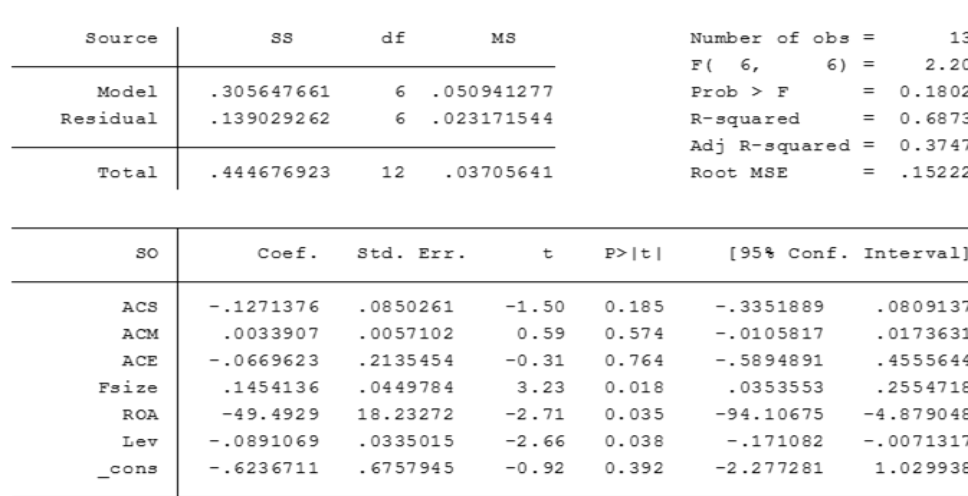
Figure 3: Results of linear regression analysis (Model